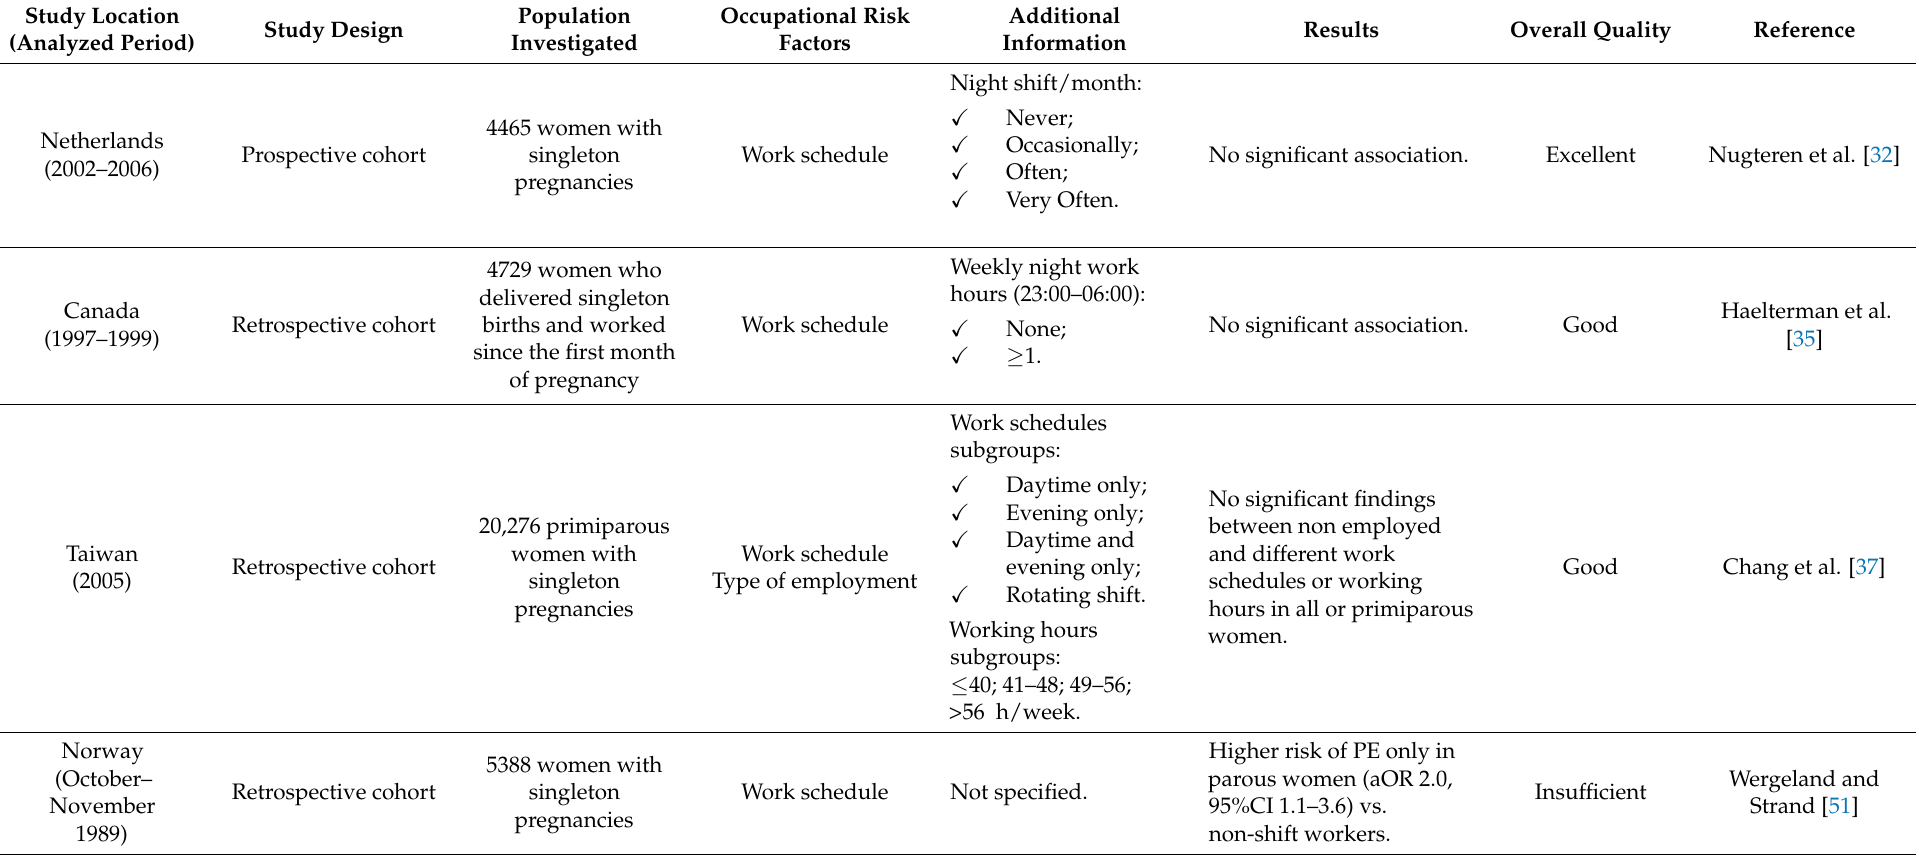
Table 5. Studies assessing the relationship between hypertensive disorders in pregnancy (HDP), including preeclampsia (PE) and gestational hypertension (GH), and shift work. Study